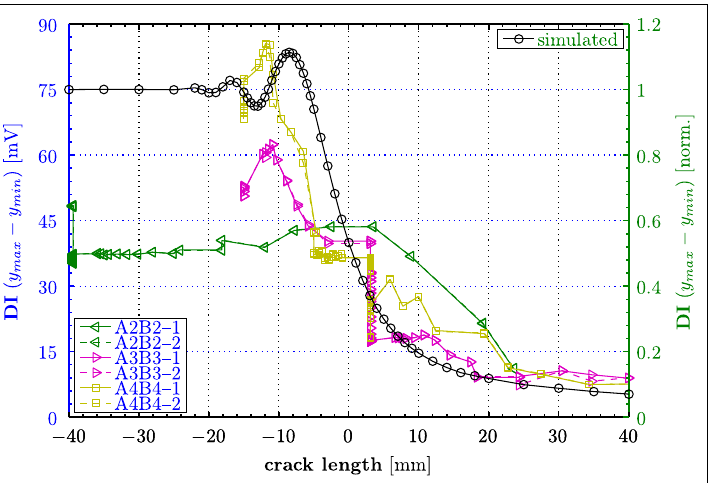
Figure 13. Experimental and simulated damage indices based on the peak-to-peak values for various crack tip positions “a” defined in Figure 11. Left and right vertical axes are given for the experimental and simulated results, respectively.